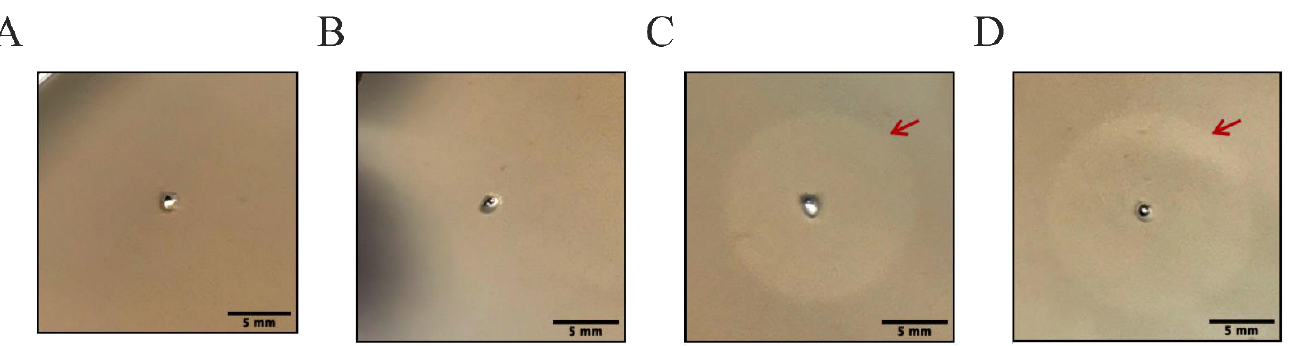
Figure 2. Testing hydrolysis activities of Tris-buffer ( A ), blank hydrogel ( B ), LysP53 ( C ), and LysP53 hydrogel ( D ). LysP53 and LysP53 hydrogel showed hydrolytic activity, while the Tris-buffer and blank hydrogel had no activity. Scale bar of 5 mm.